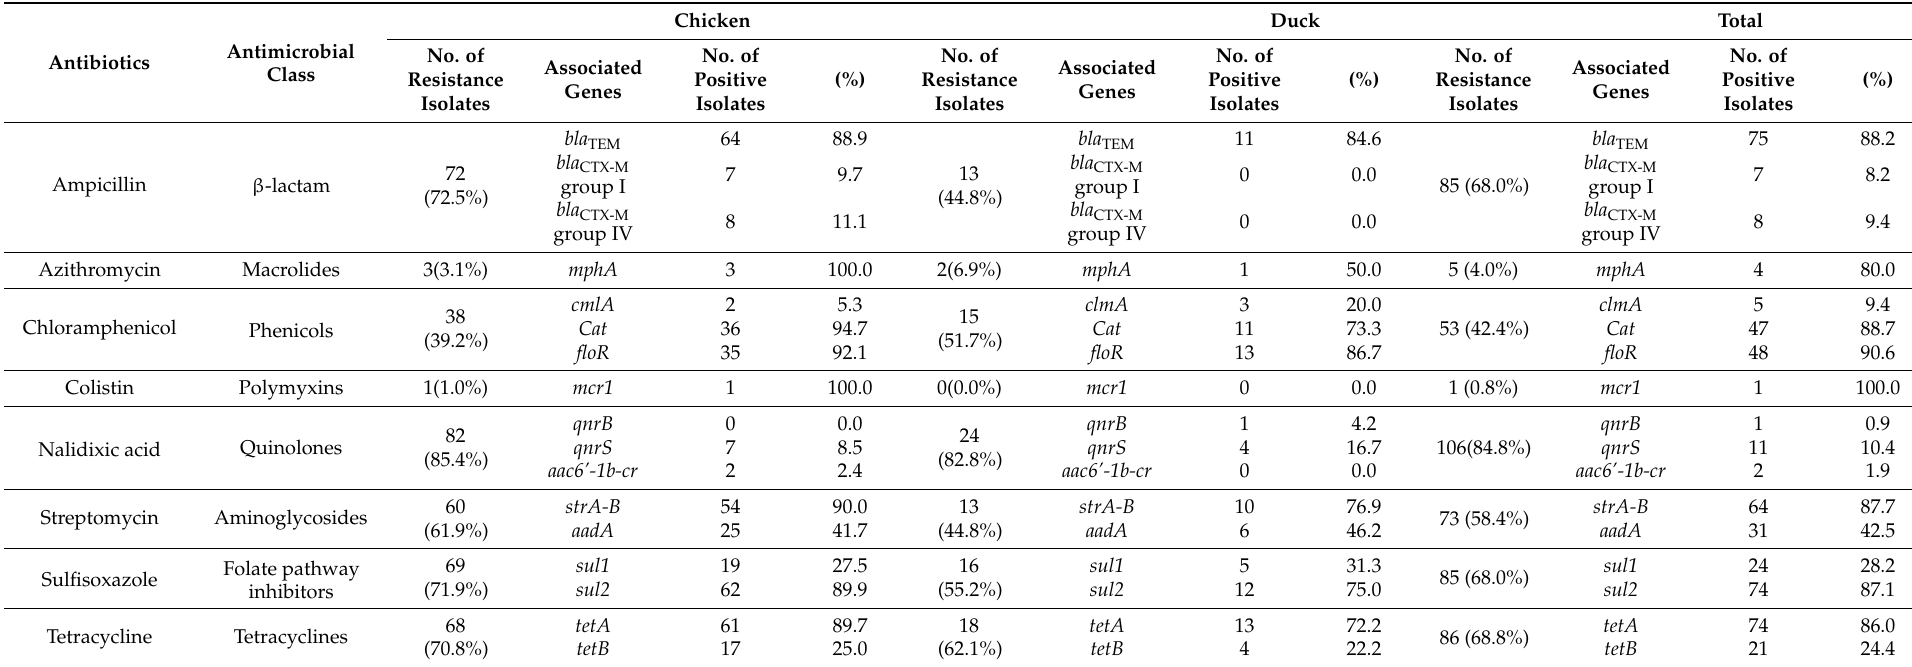
Table 5. Distribution of antimicrobial resistance genes among APEC isolates from chickens and